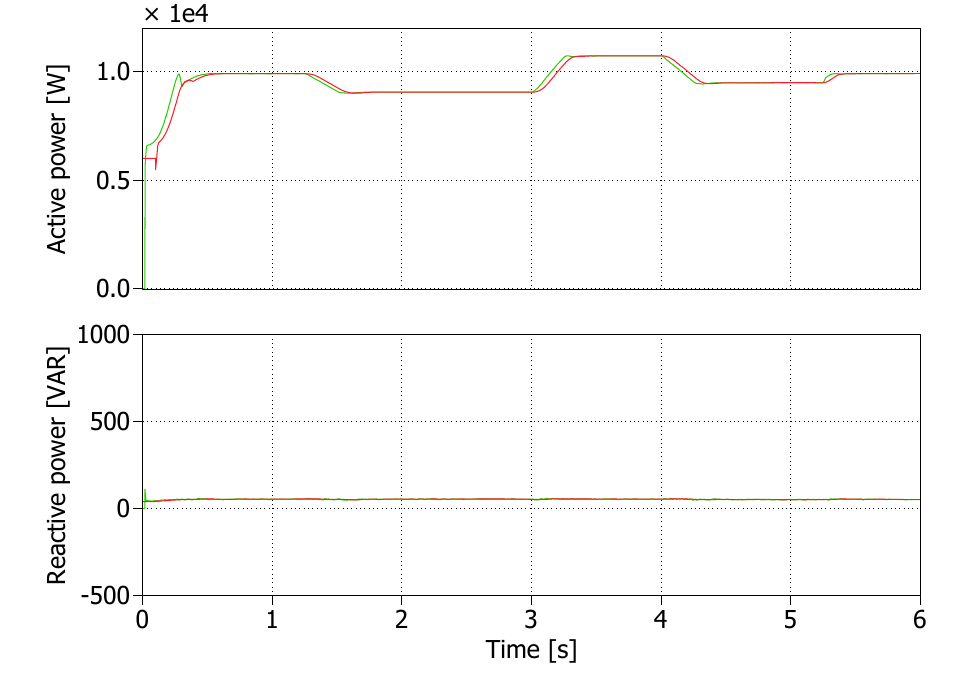
Figure 8. Active and reactive powers comparison: Red color denotes PI&PLL, while the green color denotes CVF.